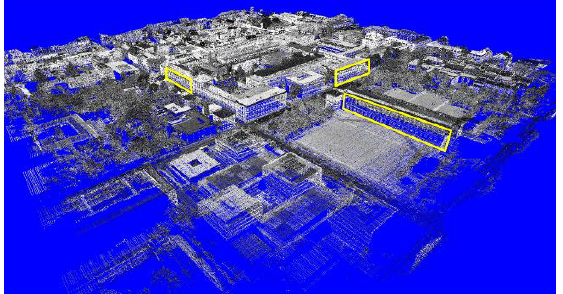
Figure 5. Point cloud of TUM area; façades shown in Section 4.2 and 4.3 are marked with yellow